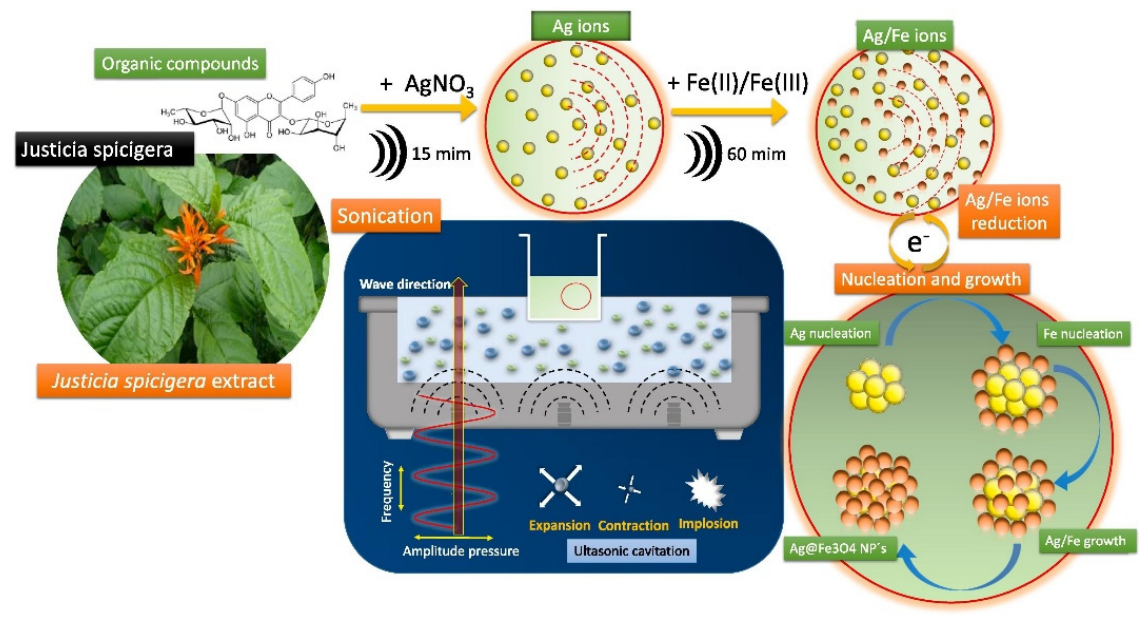
Figure 5. Green synthesis route of Fe 3 O 4 -Ag nanoparticles mediated by sonication using J . spicigera aqueous extracts. Reprinted with permission from Ref. [44]. Copyright 2020 Elsevier.